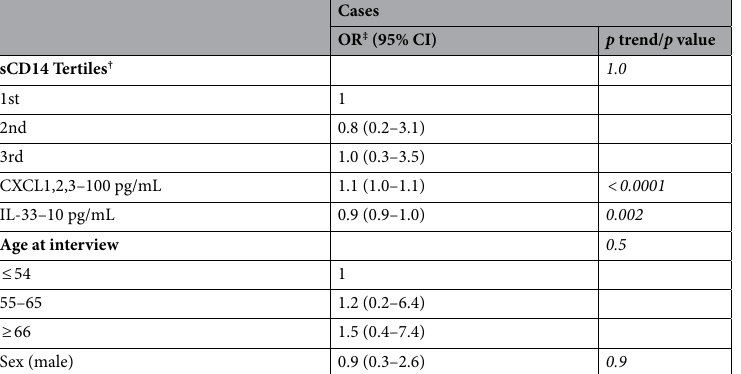
0.9 Table 3. Observed bile sCD14 levels by GBC case and gallstone control status adjusted by GBC-associated inflammatory markers. † Bile sCD14 cutoffs among GS controls: tertiles < 16,676 pg/mL (first), ≥ 16,676 and < 81,906.4 pg/mL (second), ≥ 81,906.4 pg/mL (third). ‡ Odds ratio is mutually adjusted. p trend (sCD14 Tertiles and Age) and p value (CXCL1,2,3, IL-33, CCL17, and sex): Wald test.